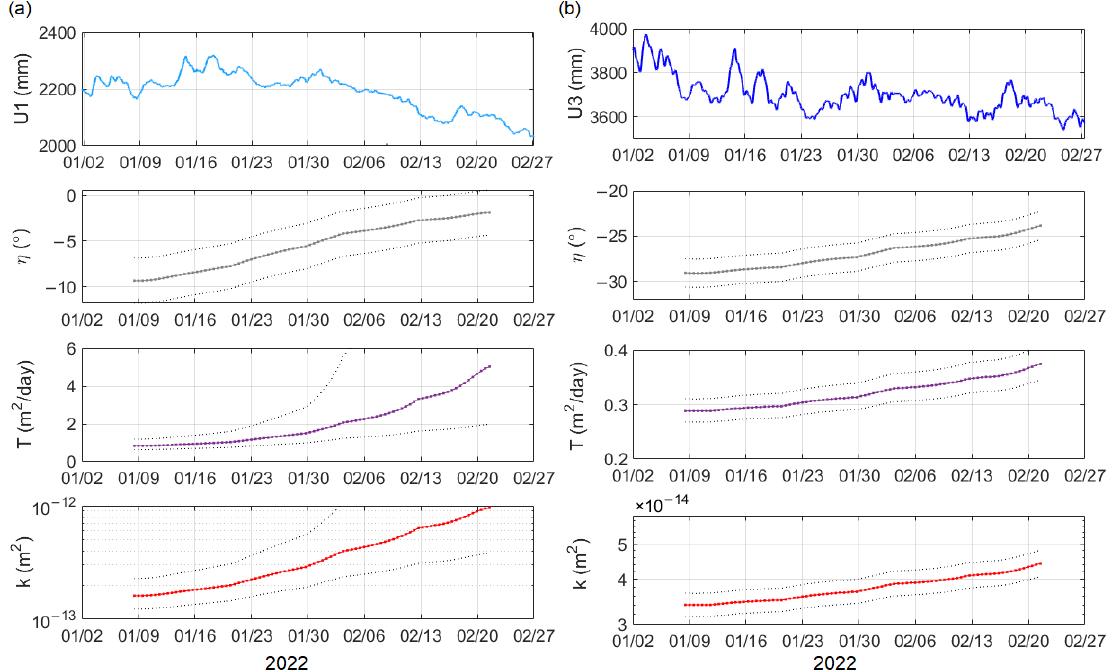
Figure 4. Diagrams (from top to bottom) of relative water level, phase shift (η), transmissivity (T), and permeability (k) according to the data obtained in the well #1 (a) and well #3 (b) for the period from January, 2022 to February, 2022. Dotted lines show error bars.